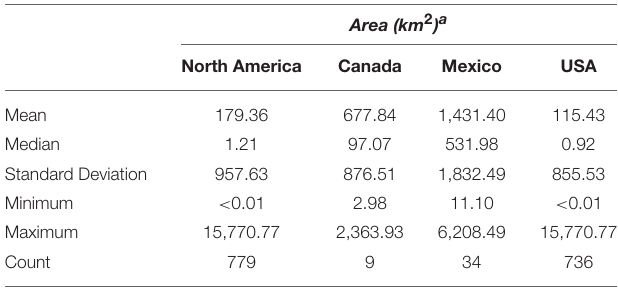
TABLE 2 | Summary statistics for the size of implemented MPAs in North America’s continental ocean estate, and by